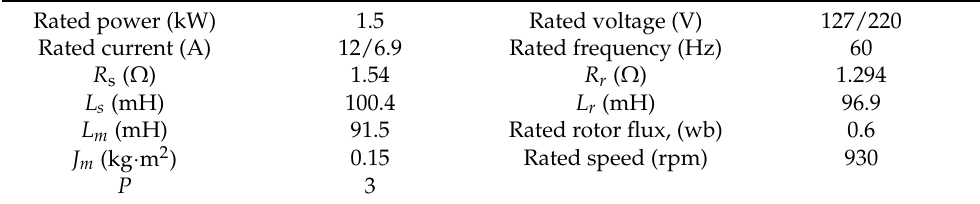
Table A1. Parameters and data specifications of the induction